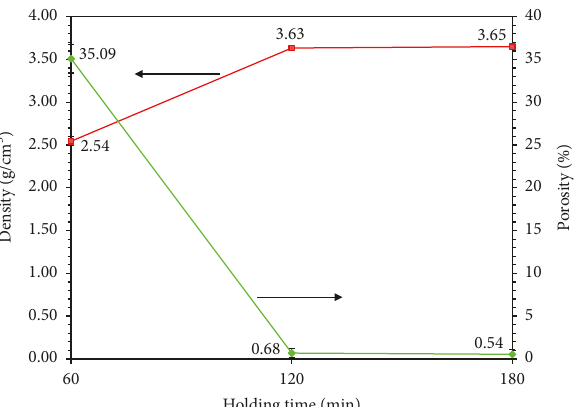
Figure 11: Effect of holding time on the sintered density and porosity of calcium titanate ceramics sintered at 1350 ° C in